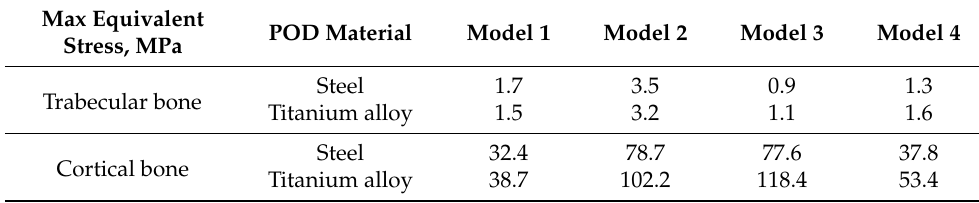
Table 3. Equivalent stress highest values in trabecular and cortical